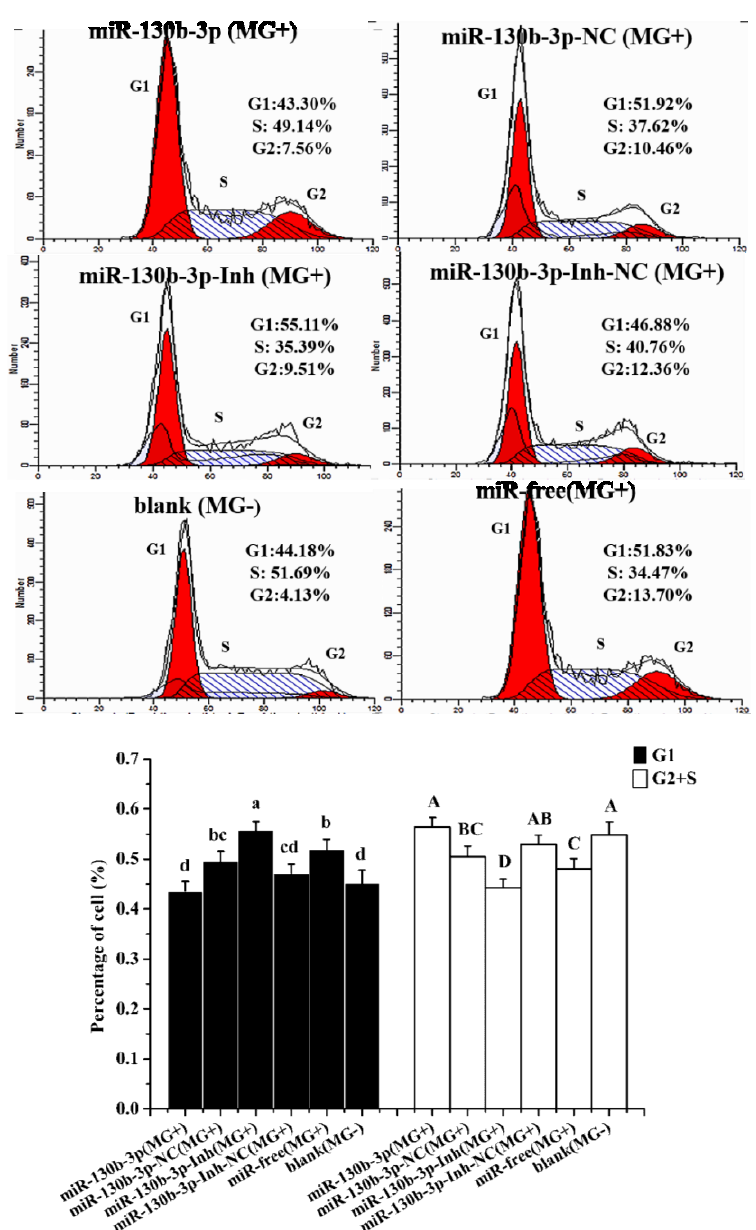
Figure 3. miR-130b-3p facilitated cell cycle progression upon MG infection. DF-1 cells cultured in 6-well culture dishes were incubated with 200 μL MG (1 × 10 10 CCU/mL) for 2 h. Then, the infected cells were transfected with miR-130b-3p, miR-130b-3p NC, miR-130b-3p-Inh or miR-130b-3p-Inh-NC. 48 h after transfection, a flow cytometer was applied to analyze the cell phase distribution. Each experiment group contained at least three duplicates. Each duplicate was measured at least three times. Values are expressed as mean ± SD. Bars with different letters in lowercase and uppercase indicate significant difference ( p < 0.05) in G1 phase and G2/S phase, respectively.